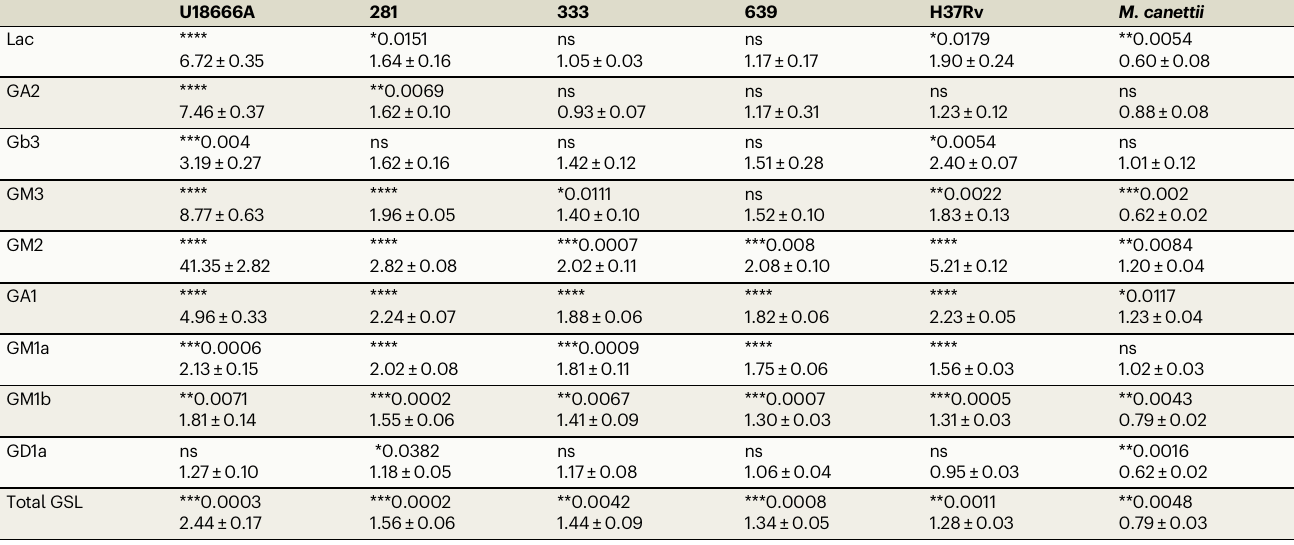
Table 2 | Summary of relative accumulation of total and speci fi c GSL species in RAW 264.7 M Φ treated with U18666A or lipid extracts from different Mtb clinical strains and M.